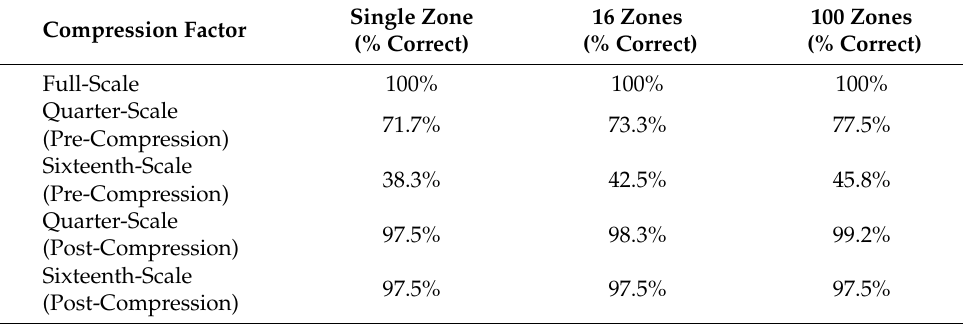
Table A1. Dresden-Nikon data-set identification